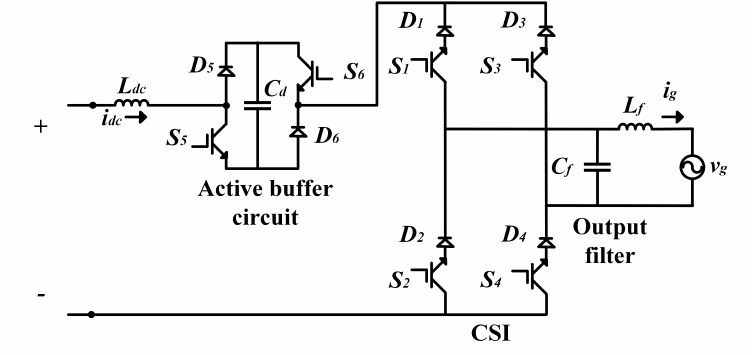
Figure 14. Single-phase current source